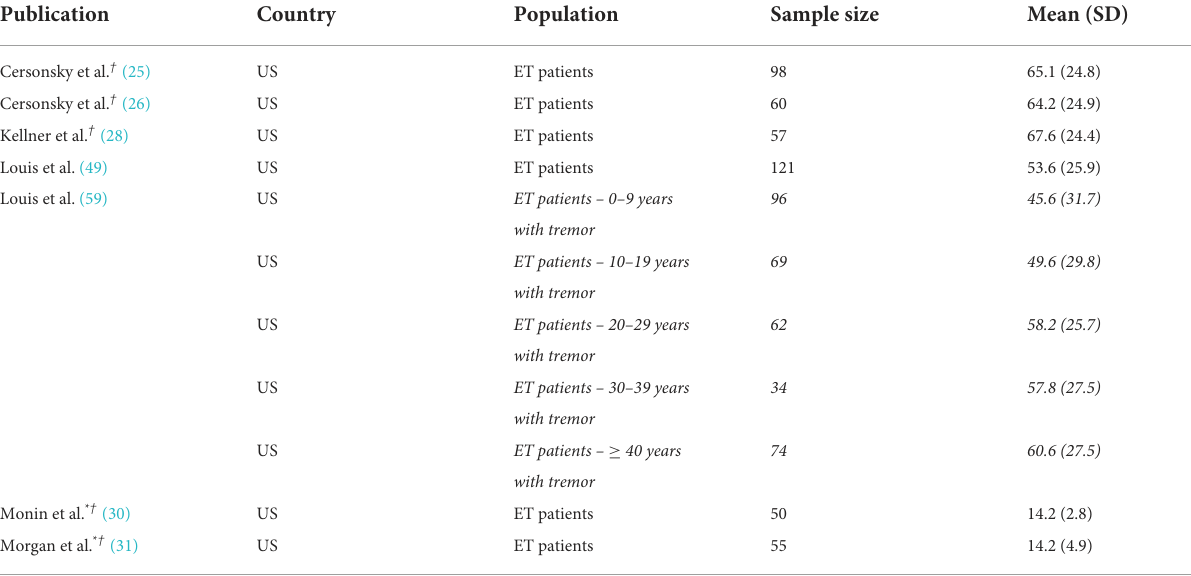
TABLE 3 Mean Columbia University Disability Questionnaire for Essential Tremor